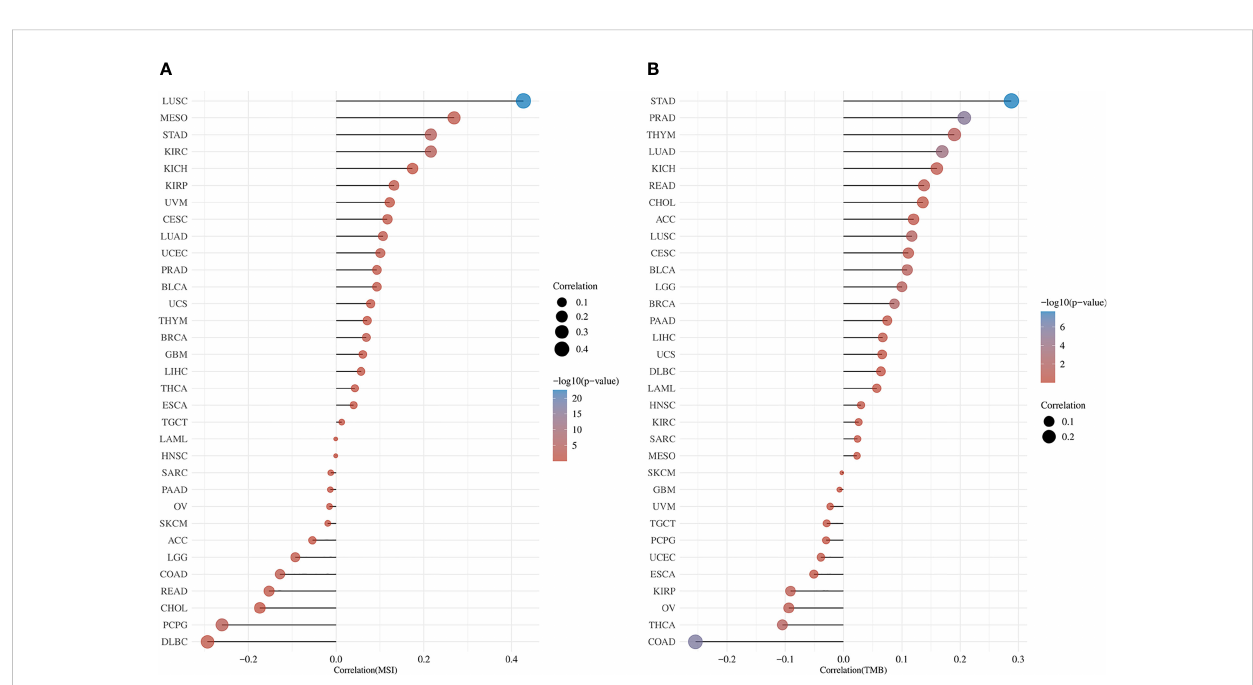
FIGURE 14 Pan-cancer analysis of RRS1 expression in association with MSI or TMB. (A) RRS1 expression and MSI correlation analyses. (B) RRS1 expression and TMB correlation